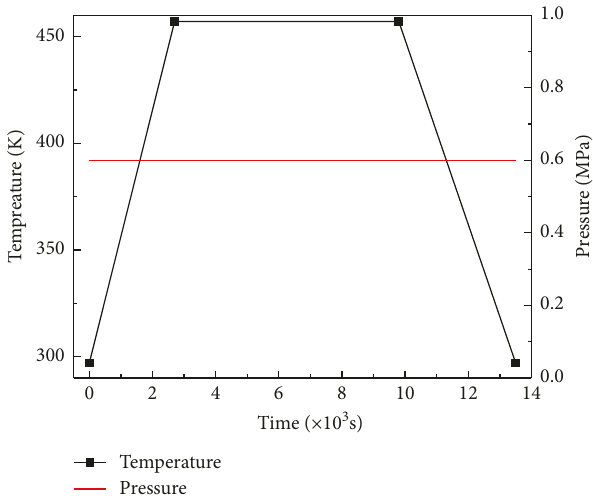
Figure 4: The curing cycle for manufacturing the composite panel.